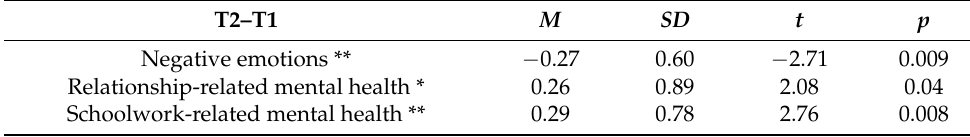
Table 7. Differences between key variables in the experiment group at T1 and T2.